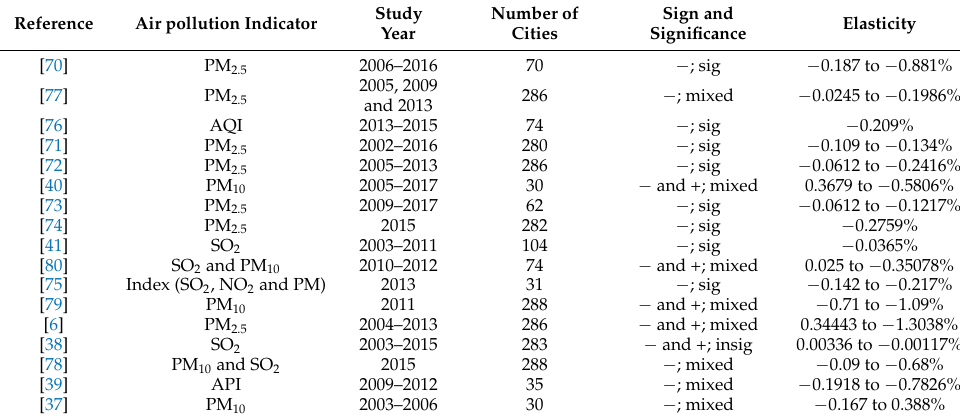
Table 1. The list of